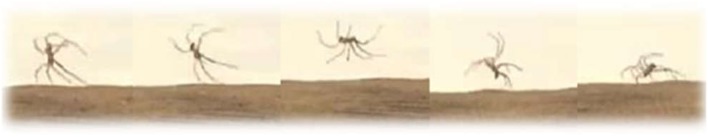
The rolling sequence generated by Cebrennus rechenbergi.